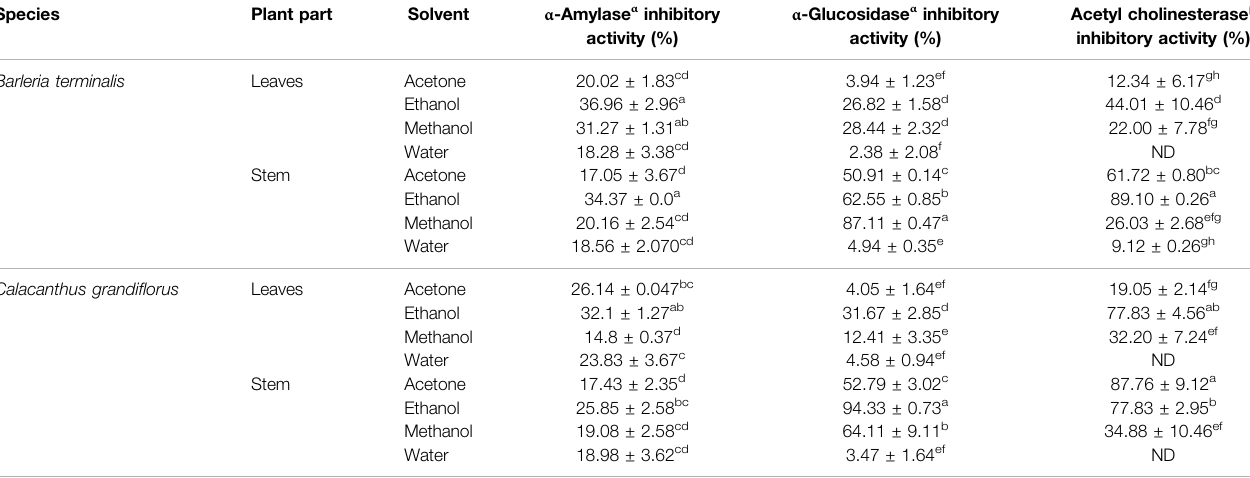
TABLE 2 | α -Amylase, α -glucosidase, and acetyl cholinesterase inhibitory activities of leaves and stem extracts of B. terminalis and C. grandi fl orus .